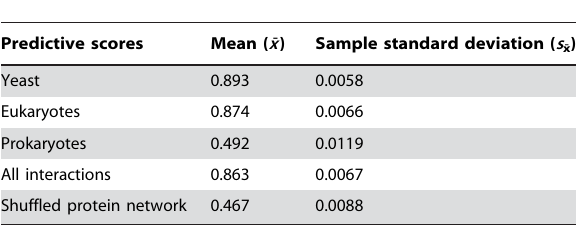
Table 5. AUC Based on Different